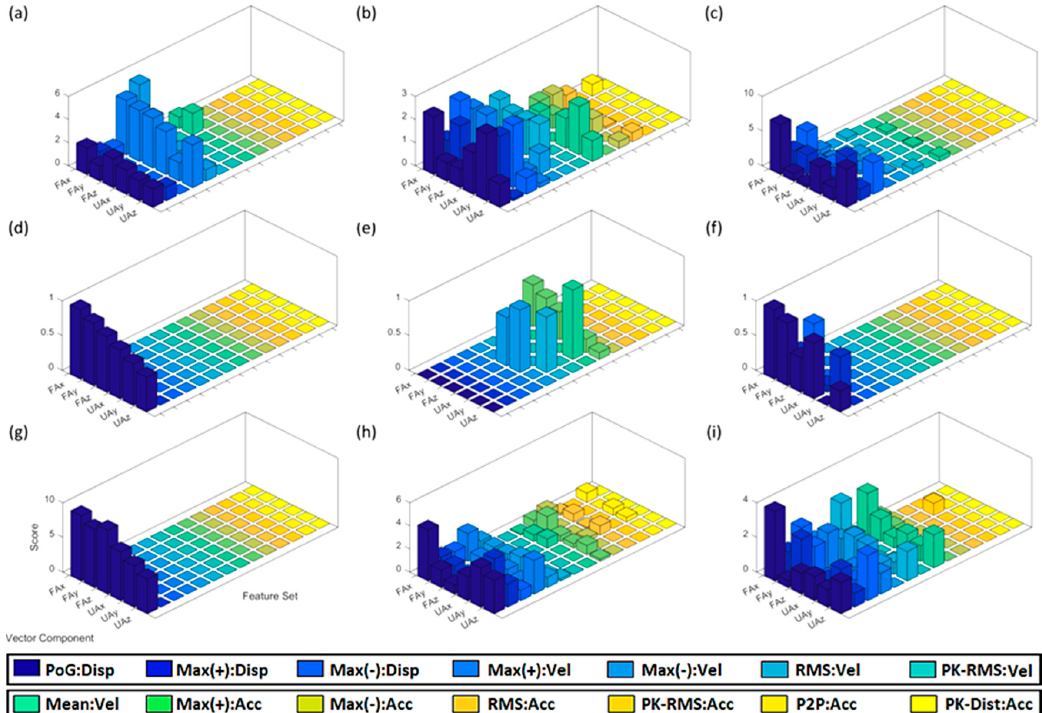
Figure 6. Cumulative kinematic feature scores of able-bodied participants grasping a ( a ) bottle, ( b ) lid, and ( c ) box across all object locations. Feature scores of amputee individual grasping a ( d ) bottle, ( e ) lid, and ( f ) box at table height and ascent. Cumulative modified feature scores of able-bodied participants grasping a ( g ) bottle, ( h ) lid, and ( i ) box at table height and ascent.